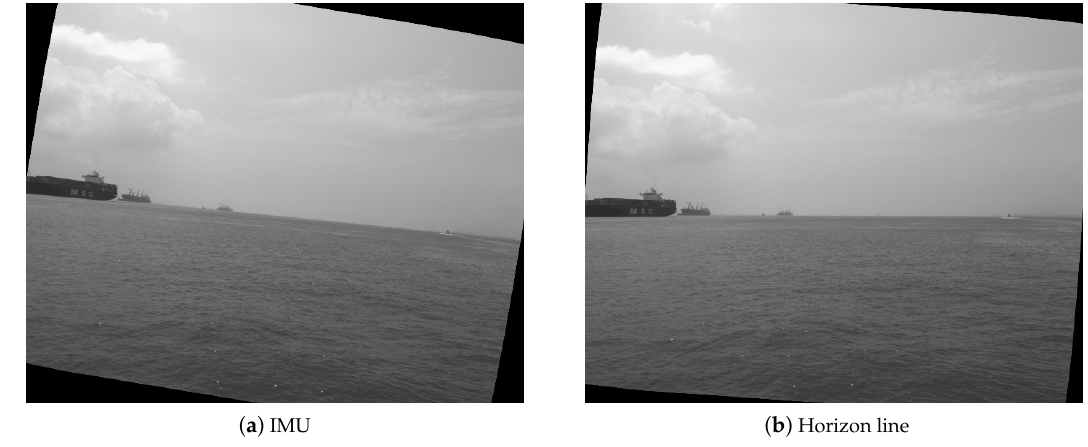
Figure 3. Roll correction using the IMU and the horizon